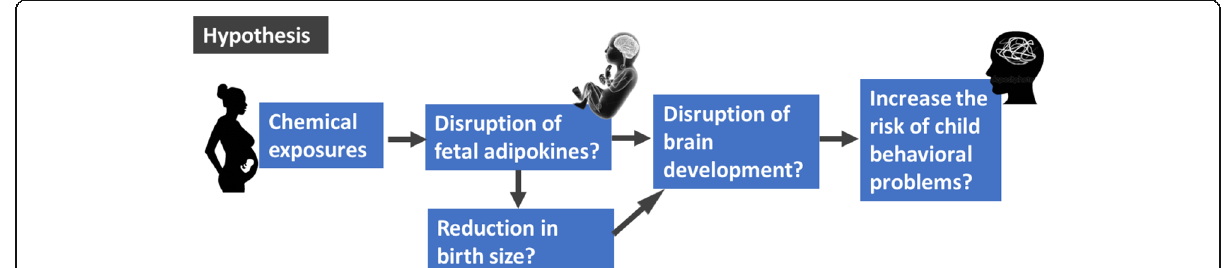
Fig. 3 Hypothesis for the pathway of chemical exposure and child behavioral problems